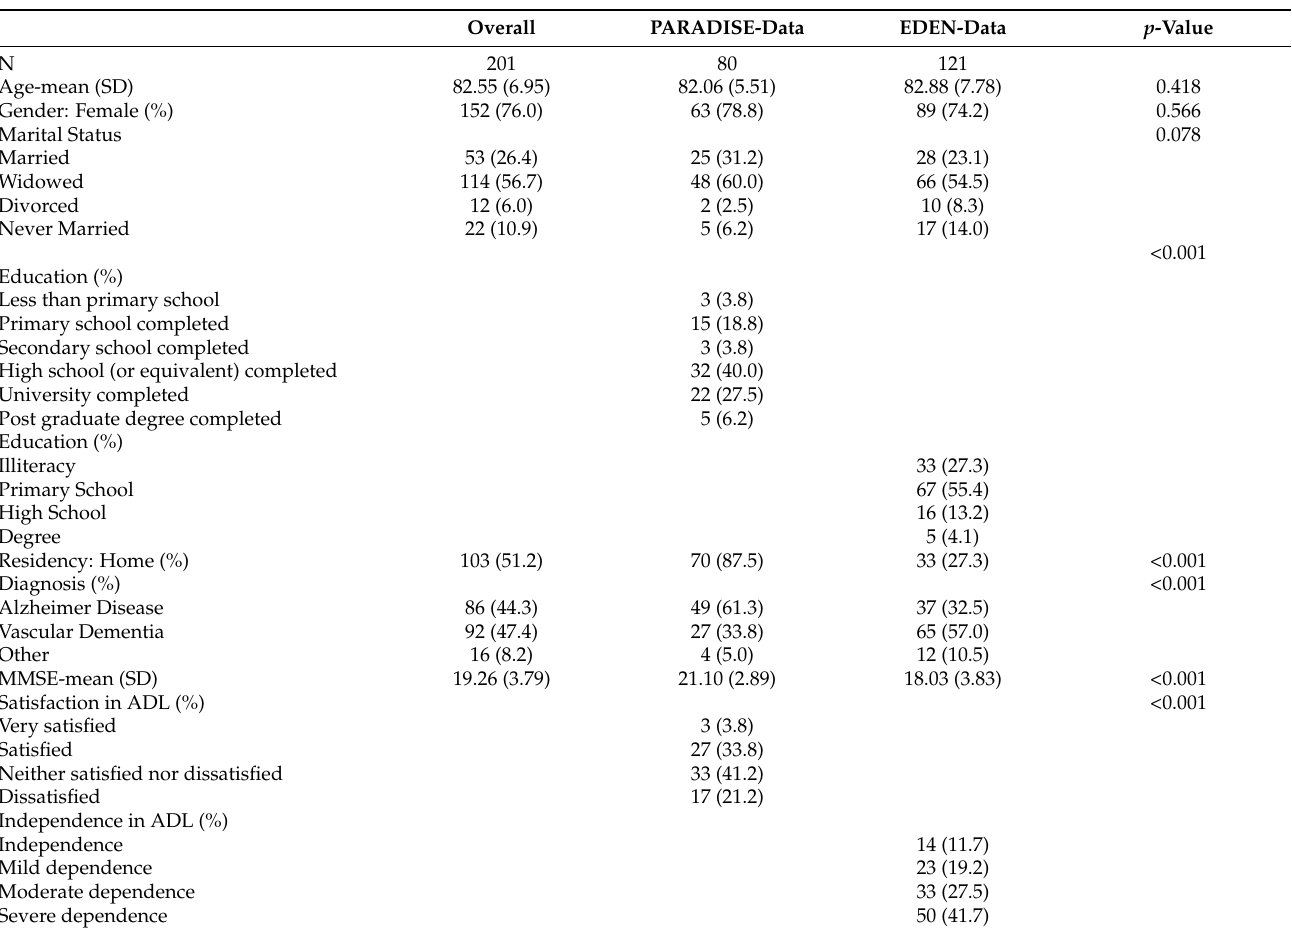
Table 2. Sample Descriptives Stratified by Data